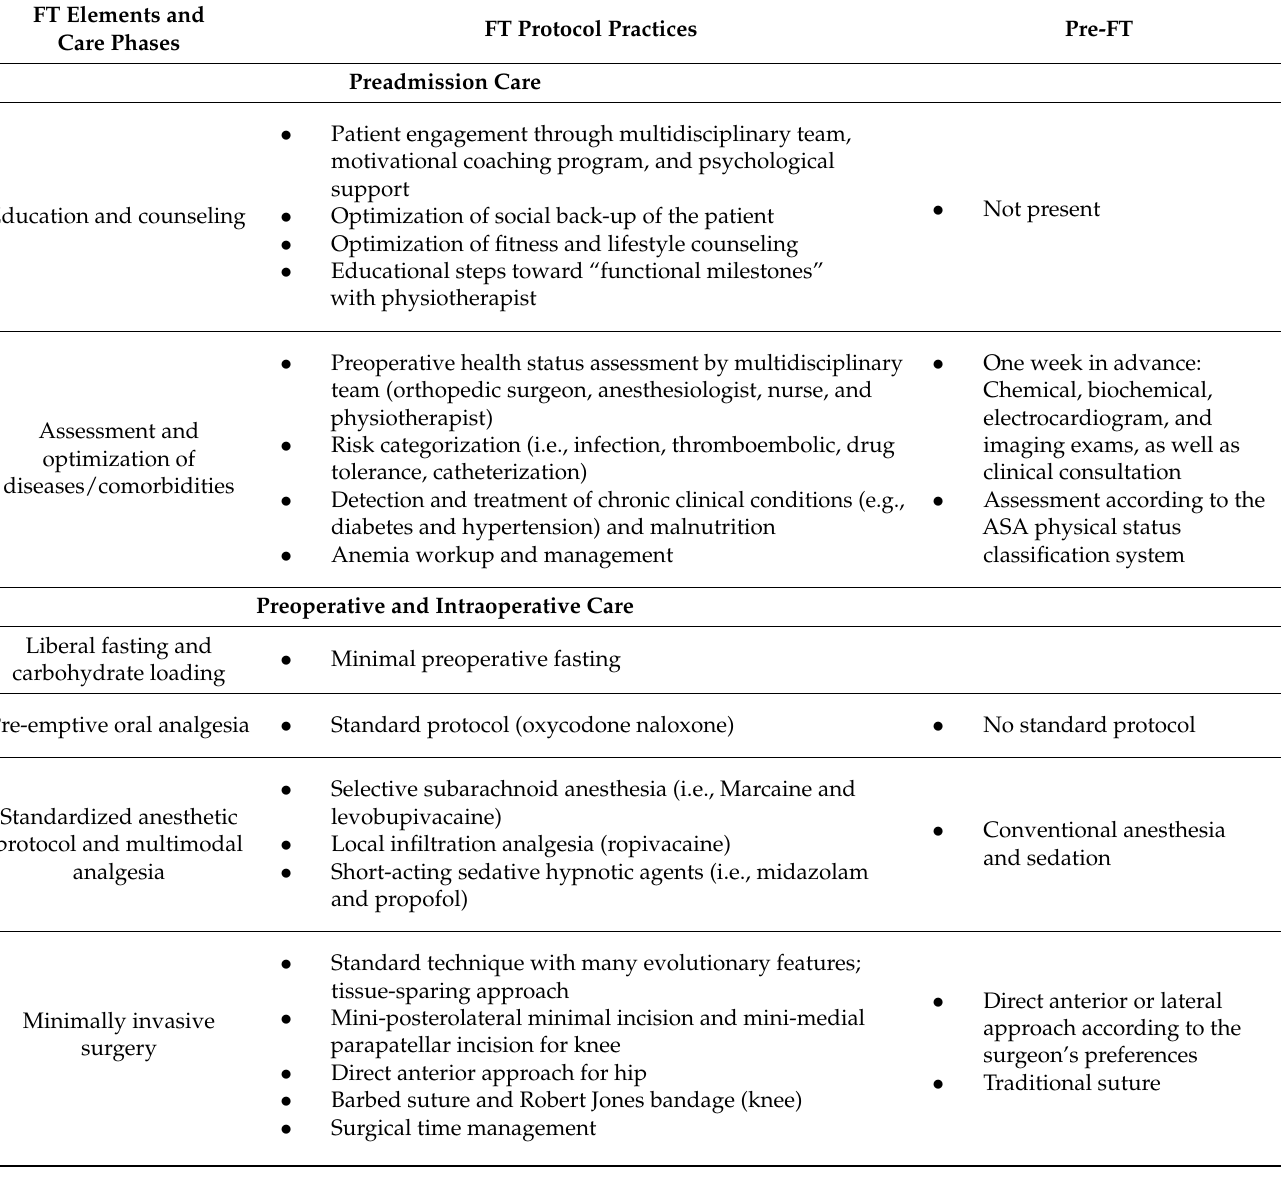
Table 1. Main characteristics of the fast-track (FT) protocol and the pre-fast-track (pre-FT) care at Tione Hospital, Trento (Italy). FT Elements and Care